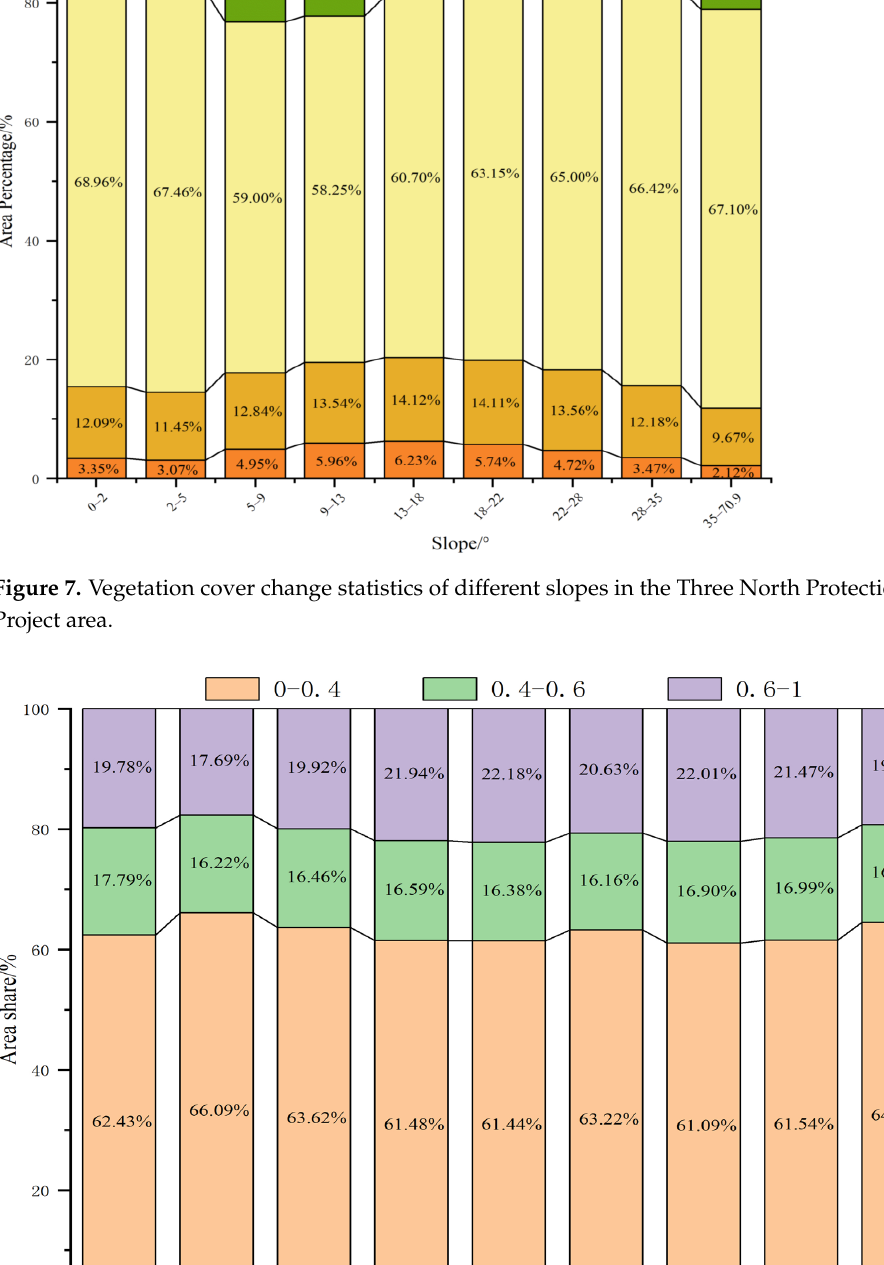
Figure 9. Vegetation cover change statistics of different slope orientations in the Three North Pro- tection Forest Project area.